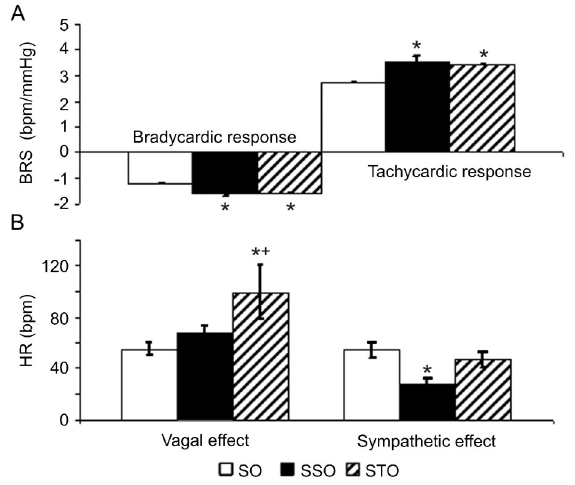
Figure 2. Baroreflex sensitivy (BRS) evaluated by bradycardic and tachycardic responses to blood pressure changes ( A ) and autonomic control of heart rate (HR) reflected in vagal and sympathetic effects ( B ) in sedentary ovariectomized rats (SO), sedentary ovariectomized rats treated with simvastatin (SSO) and trained ovariectomized rats treated with simvastatin (STO). *P , 0.05 vs SO group; + P , 0.05 vs SSO group (one-way ANOVA followed by the Student-Newmann-Keuls test).